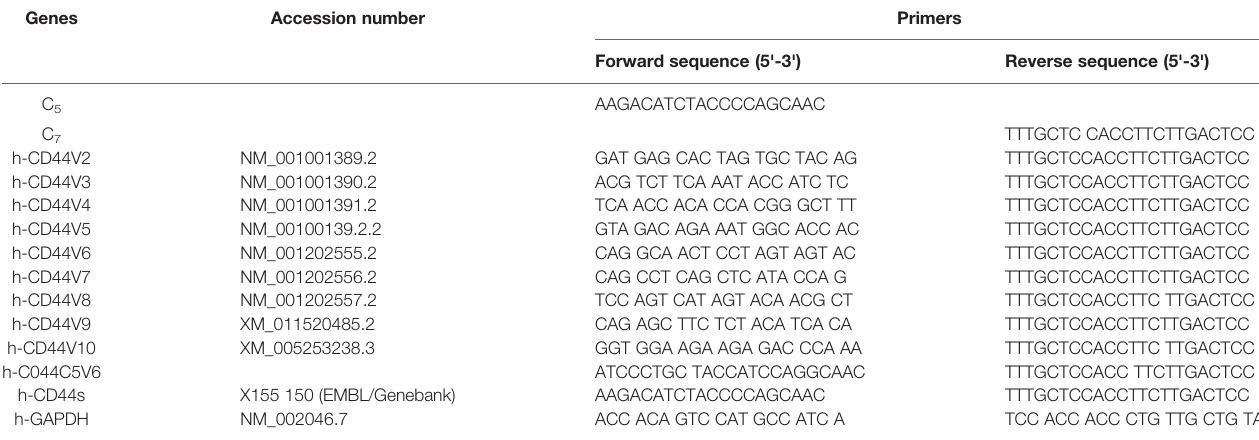
TABLE 1 | CD44 exon speci fi c PCR examined using 5' primers complementary to individual variable exons and a primer to the 3' constitutive exon 7.